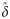
Relationships between various parameters in Eq (1) for data published in [2].A. Predicted dispersal distance (log(δ^)) vs effective population density (log(D^e)). B. Predicted dispersal distance (log(δ^)) vs surface area (log(S^)) occupied by the effective population. C. Regression coefficient (log(b)) vs effective population density (log(D^e)). D. Effective population size (log(N^e)) vs effective population density (log(D^e)). E. Effective population size (log(N^e)) vs surface area (log(S^)) occupied by the effective population. F. Surface area (log(S^)) occupied by the effective population vs effective population density (log(D^e)).